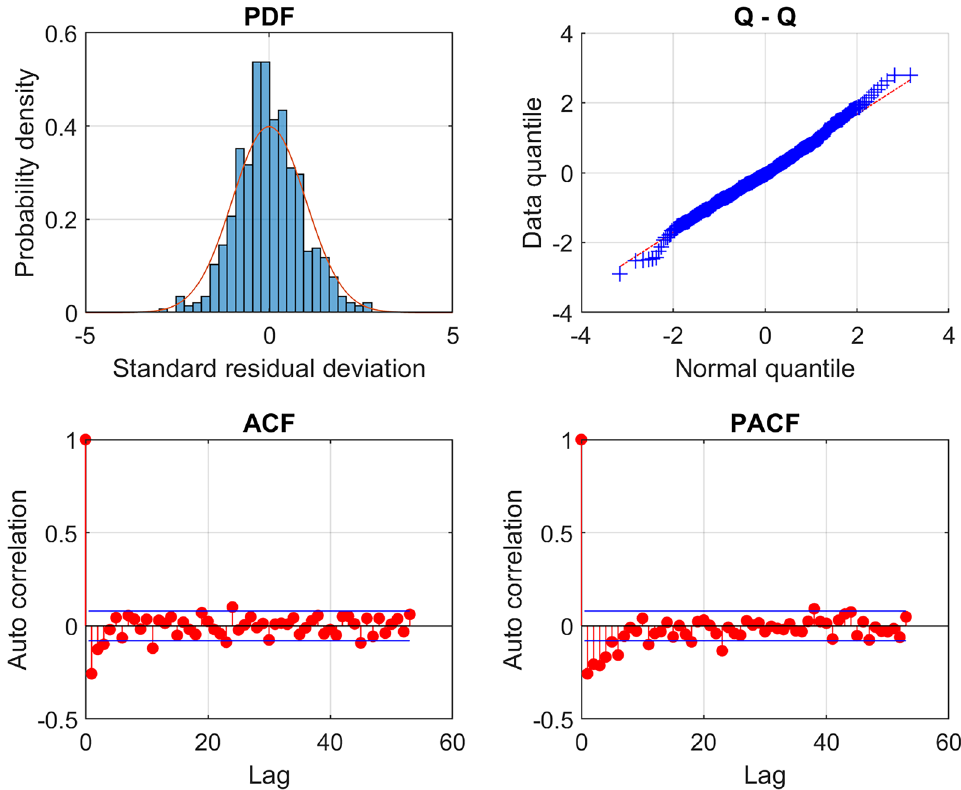
Figure 3. Diagnostics for the standardised residual deviations corresponding to the results of the GP regression shown in Fig. 2. A scaled histogram of those deviations compared against the probability density function for the standard normal distribution N(0, 1), a QQ-plot of the quantiles of the deviations compared against the quantiles of N(0, 1), and the sample autocorrelation (ACF) and sample partial autocorrelation (PACF) functions for various